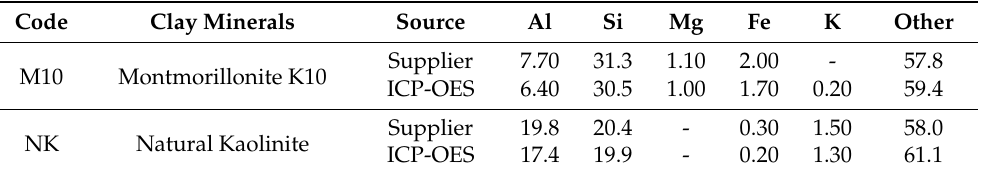
Table 1. Elemental composition in wt% of the natural kaolinite and montmorillonite K10—Sigma Aldrich.